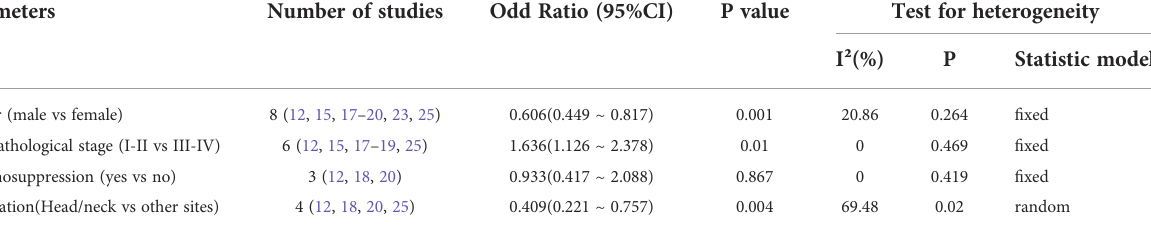
TABLE 4 Meta-analysis of reported clinicopathological characteristics in the included